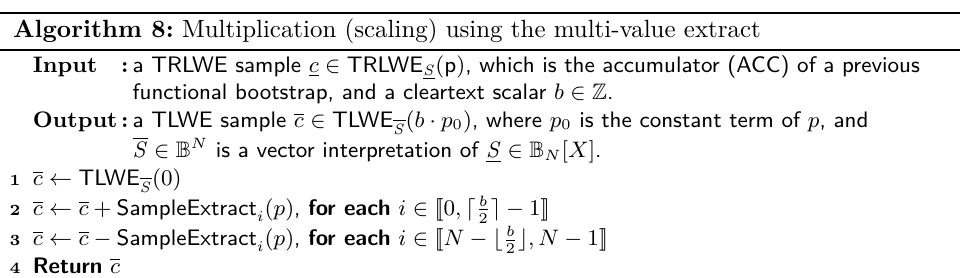
Algorithm 8: Multiplication (scaling) using the multi-value